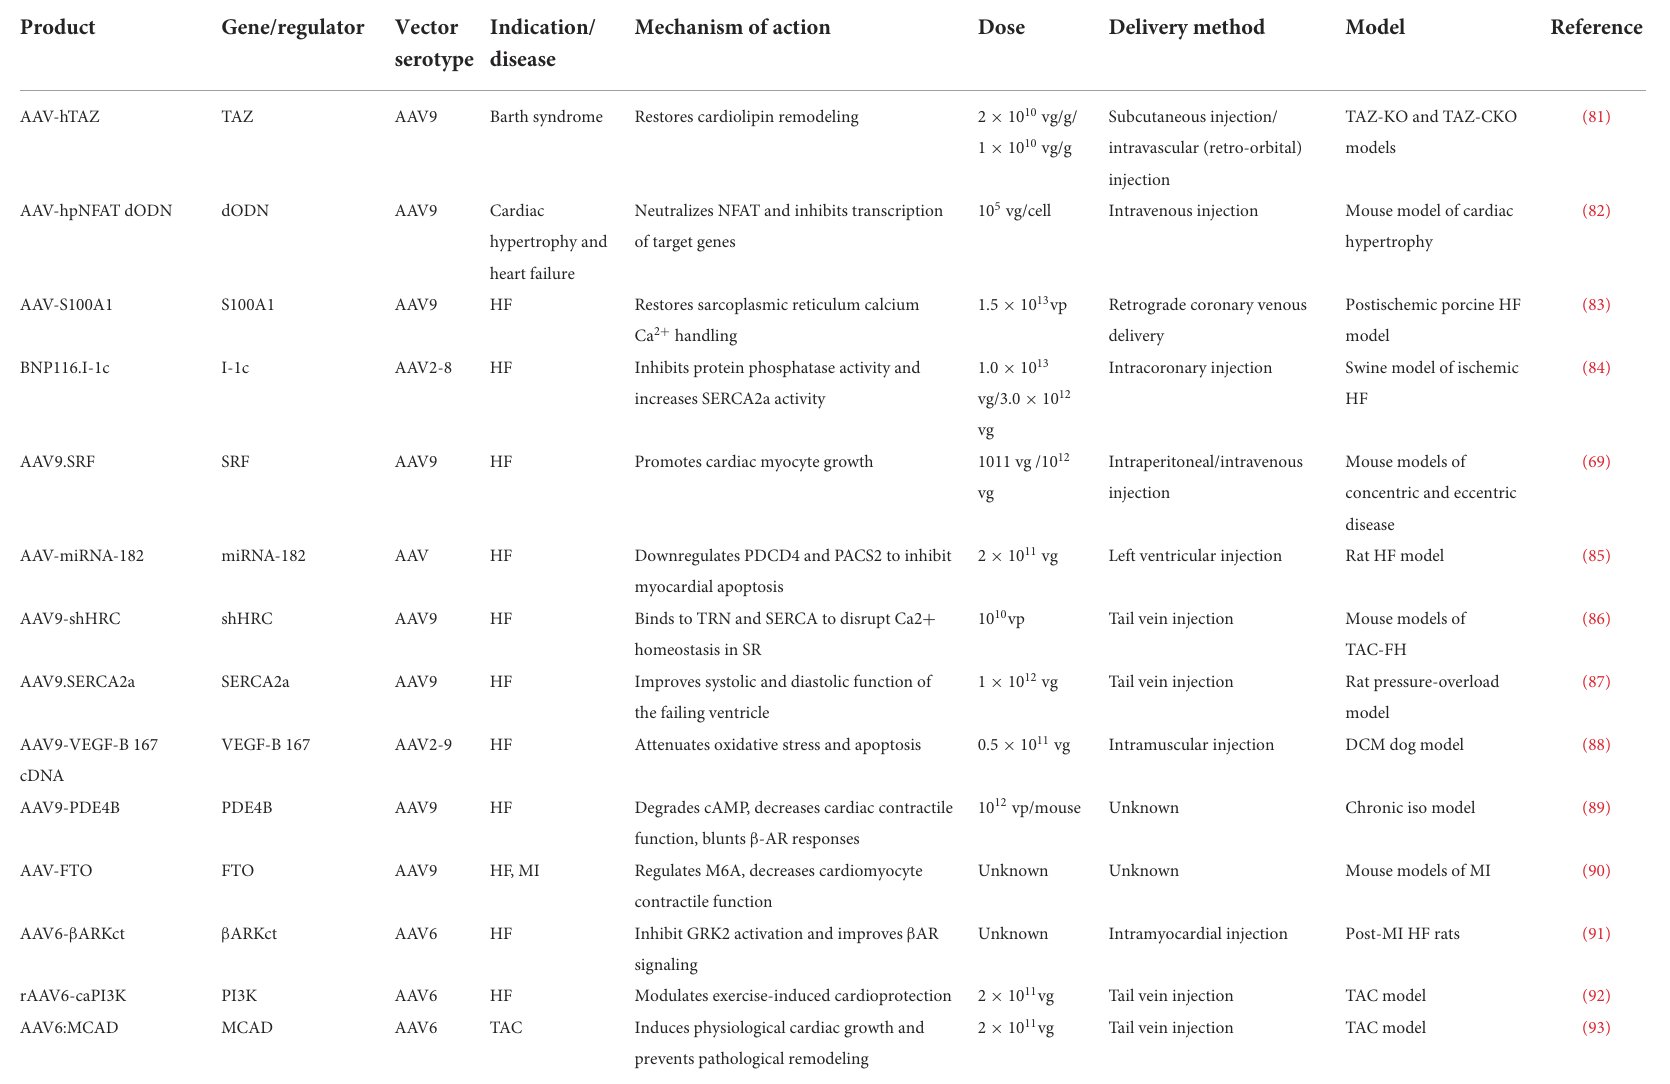
TABLE 2 Preclinical application of AAV in cardiovascular